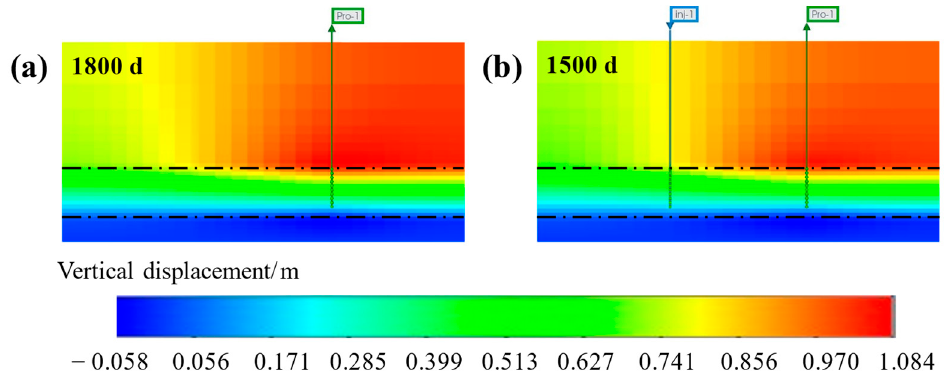
Figure 10. Comparison of the vertical displacement in Case A ( a ) and Case B ( b ) with the same C G .